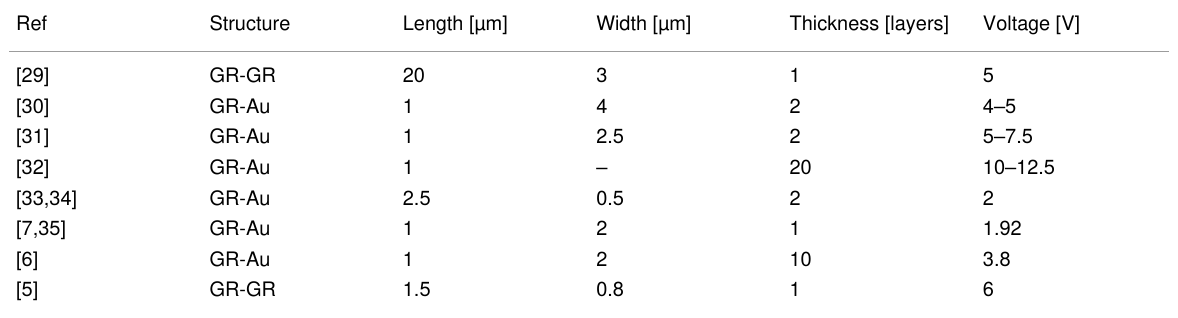
Table 2: Structures and pull-in voltages of GR switches.